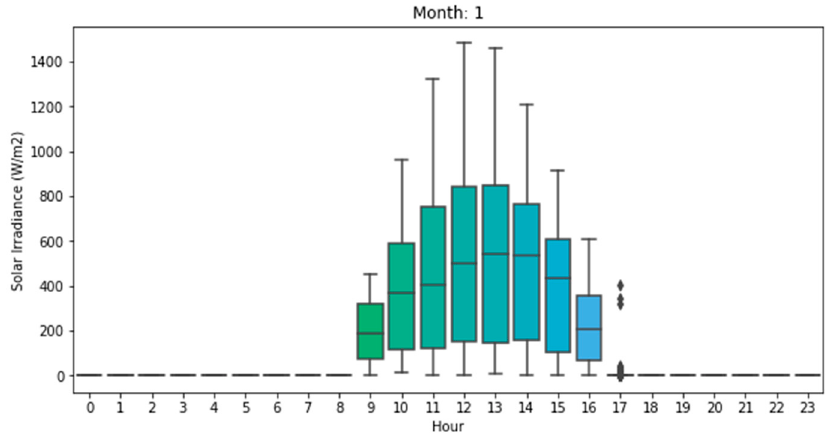
Figure 3. Box-whisker plot of solar irradiance for the days in January from 2005 to 2016. The bold points represent values identified as outliers following Equation (1) with p = 1.5. To each hour is associated a different color of box.